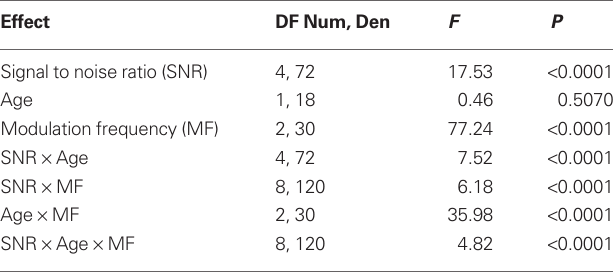
Table 3 | Tests of main effects of signal-to-noise ratio (SNr), age and modulation frequency, as well as all their interaction factors on AMFr amplitudes using repeated measures ANOVA.